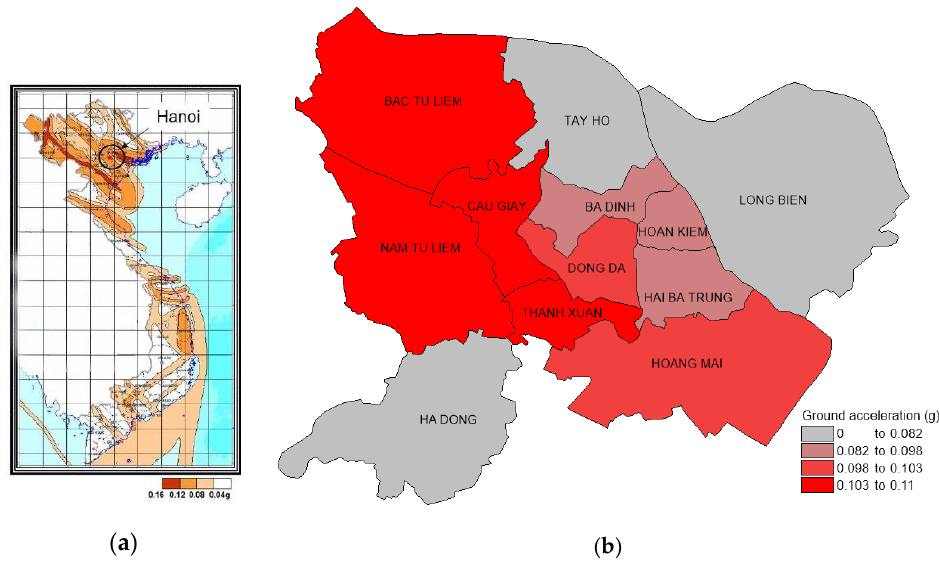
Table 3. Values of parameters describing elastic response spectra [14,15] .